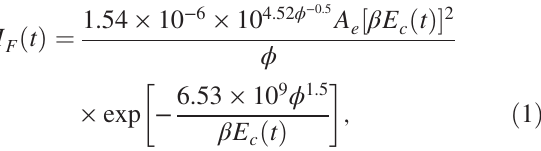
FIG. 5. Longitudinal field profile of the normalized electric field of the rf gun (blue curve) and the normalized magnetic field of the focusing solenoid (red curve). The electric field decreases monotonically from the cathode ( z ¼ 0 ) to the gun exit ( z ¼ 7 . 7 cm) due to the single-cell design.